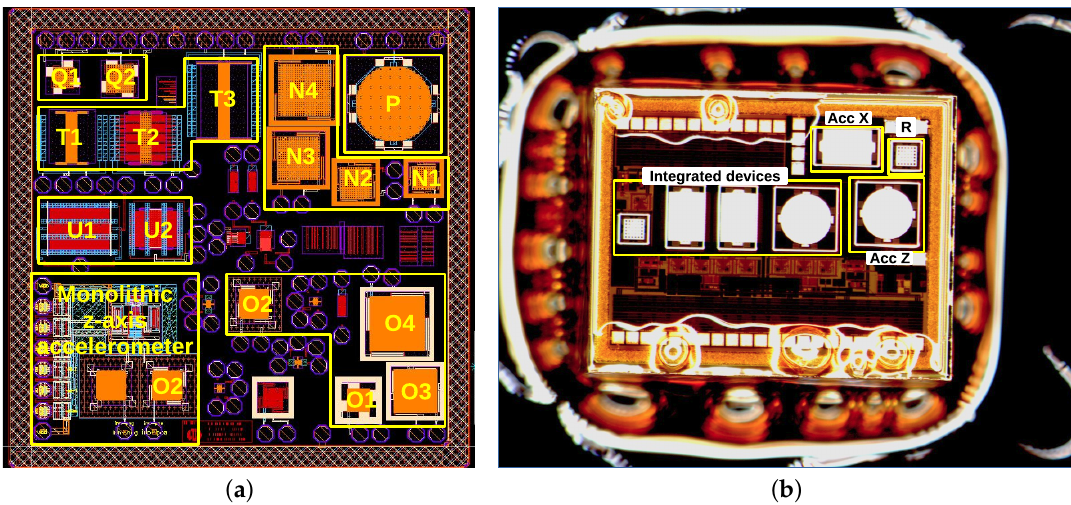
Figure 6. Layout of Bailed chip fabricated in SG25H3 full process ( a ). The dimensions are 2.2 mm × 2.2 mm including the 200 µ m wide metal guardring. Microphotography of 2 mm × 2.5 mm Released chip ( b ). The manually applied photoresist is used to stick the sample to a carrier wafer and is deliberately covering the pads to correct the etching mask